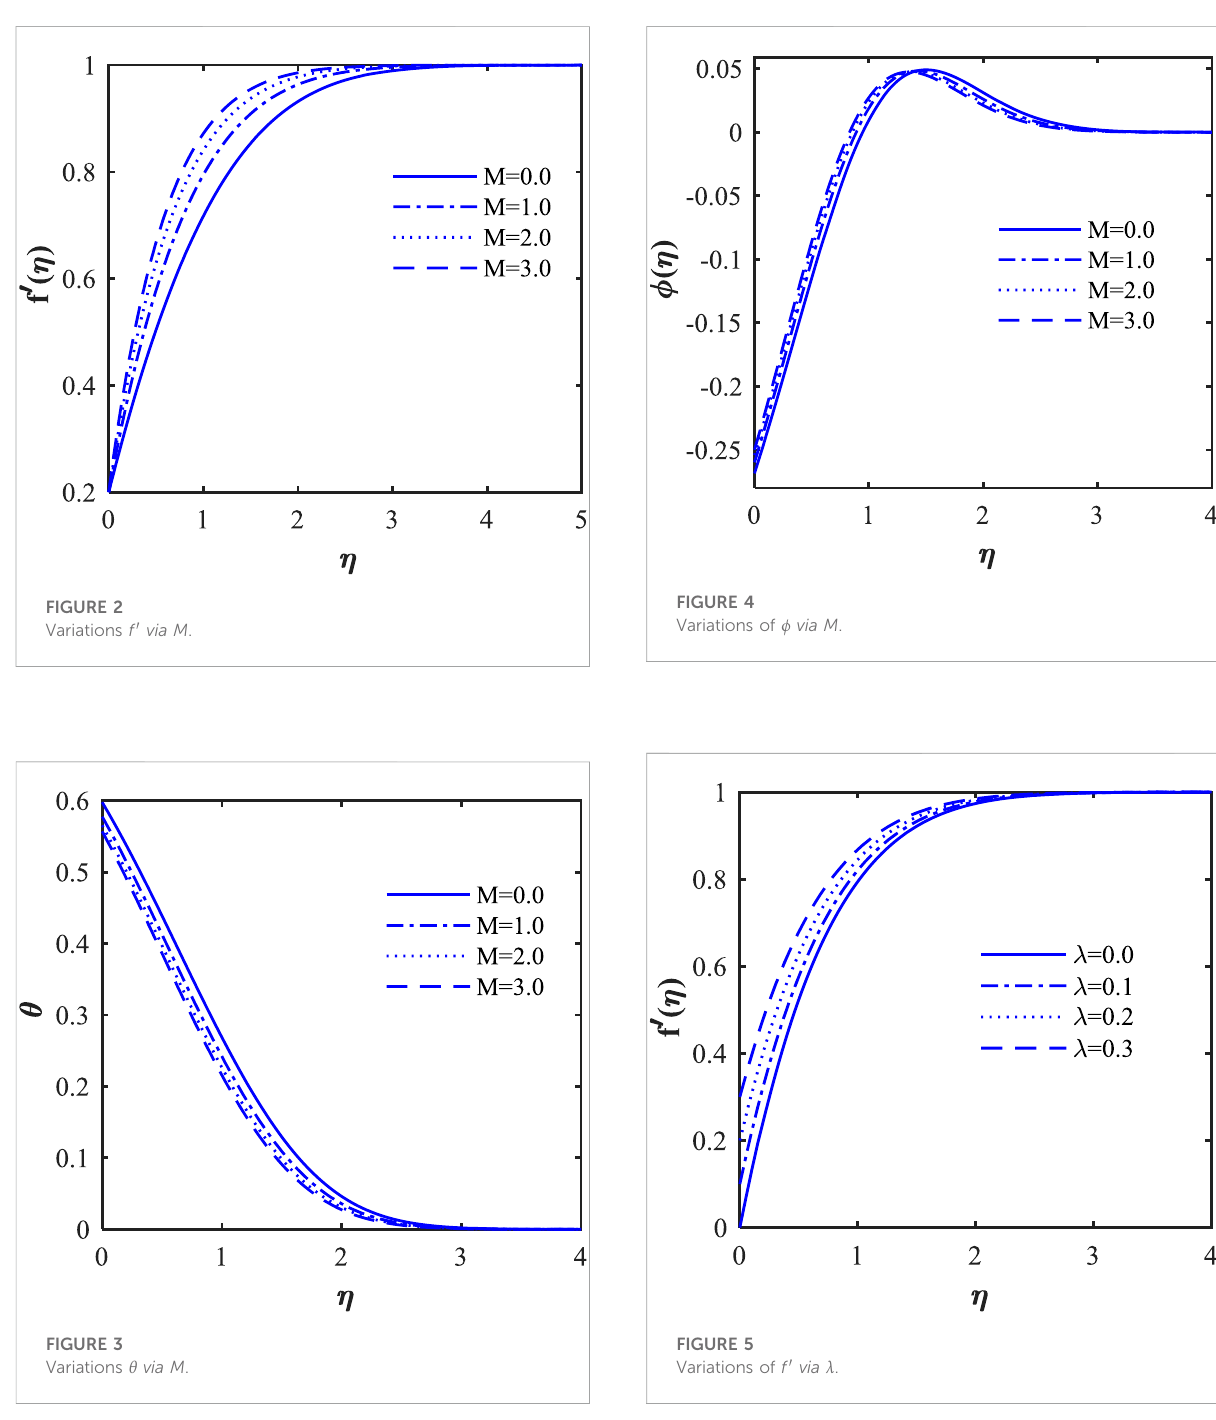
FIGURE 3 Variations θ via M .